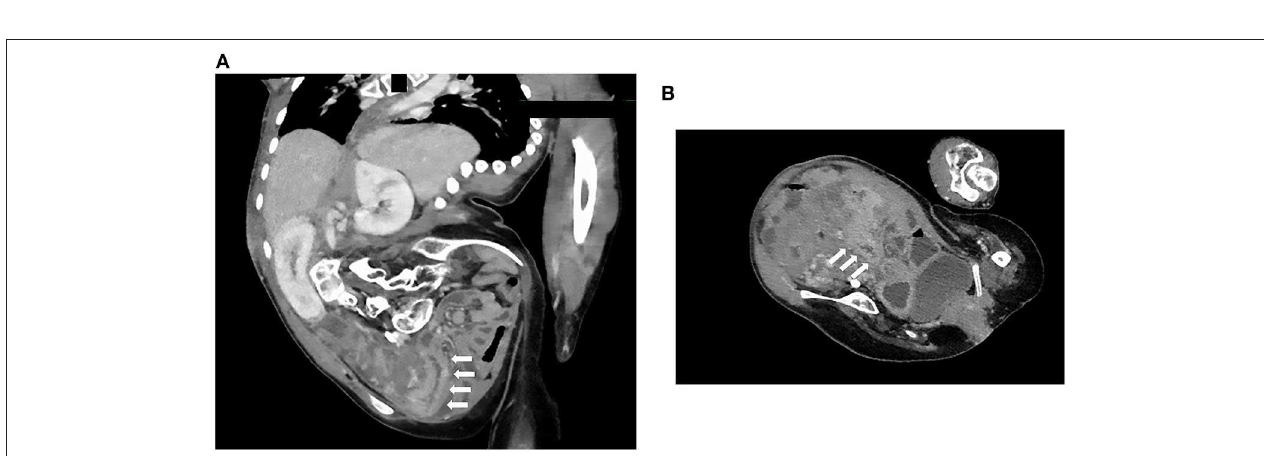
FIGURE 3 | Total colonoscopy. (A,B) The intussusception was gradually reduced with endoscopic insufflation. (C) Ulcer formation was observed in the cecum, but no neoplastic lesion was observed. (D) Almost no abnormal findings were found between the ileocecum and the distal ileum.